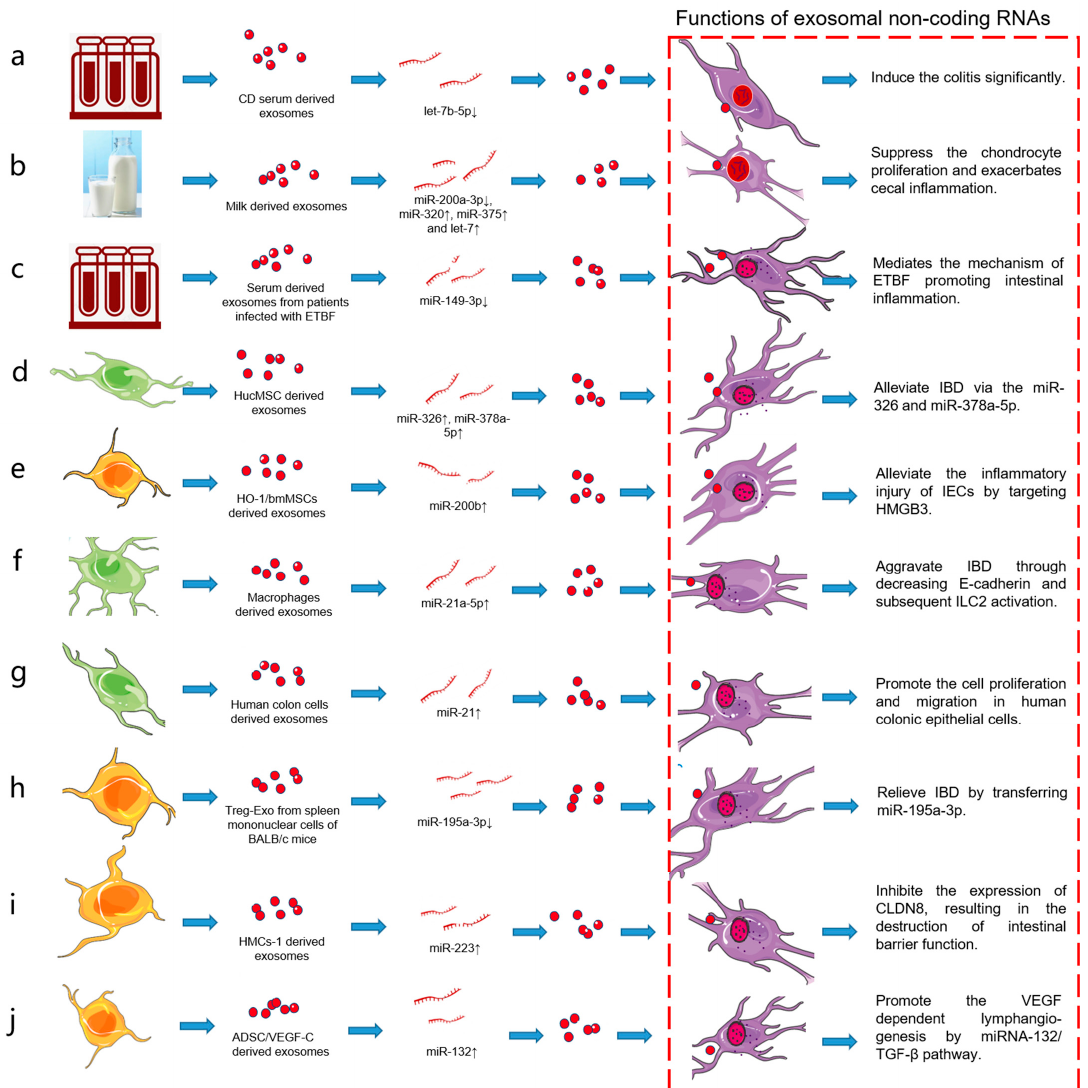
Figure 2. Exosomes from different sources affect the pathogenesis of IBD. Exosomes play an important role in the pathogenesis of IBD through their non-coding RNA, involving immune response disorder, barrier function, and intestinal microbiota; ( a ) CD serum-derived exosomes; ( b ) milk-derived exosomes; ( c ) serum-derived exosomes from patients infected with ETBF; ( d ) HucMSC-derived exosomes; ( e ) HO-1/bmMSCs-derived exosomes; ( f ) macrophage-derived exosomes; ( g ) human colon cells-derived exosomes; ( h ) Treg-Exo from spleen mononuclear cells of BALB/c mice; ( i ) HMCs-1-derived exosomes; ( j ) ADSC/VEGF-C-derived exosomes. Macrophage pyroptosis, the cell death process after NOD-like receptor family pyrin domain-containing 3 (NLRP3) inflammasome activation, is considered to be part of the cause of an abnormal immune response in IBD pathogenesis [42]. Macrophage pyroptosis plays an important regulatory role in the reduction in colitis by hucMSC-derived exo-